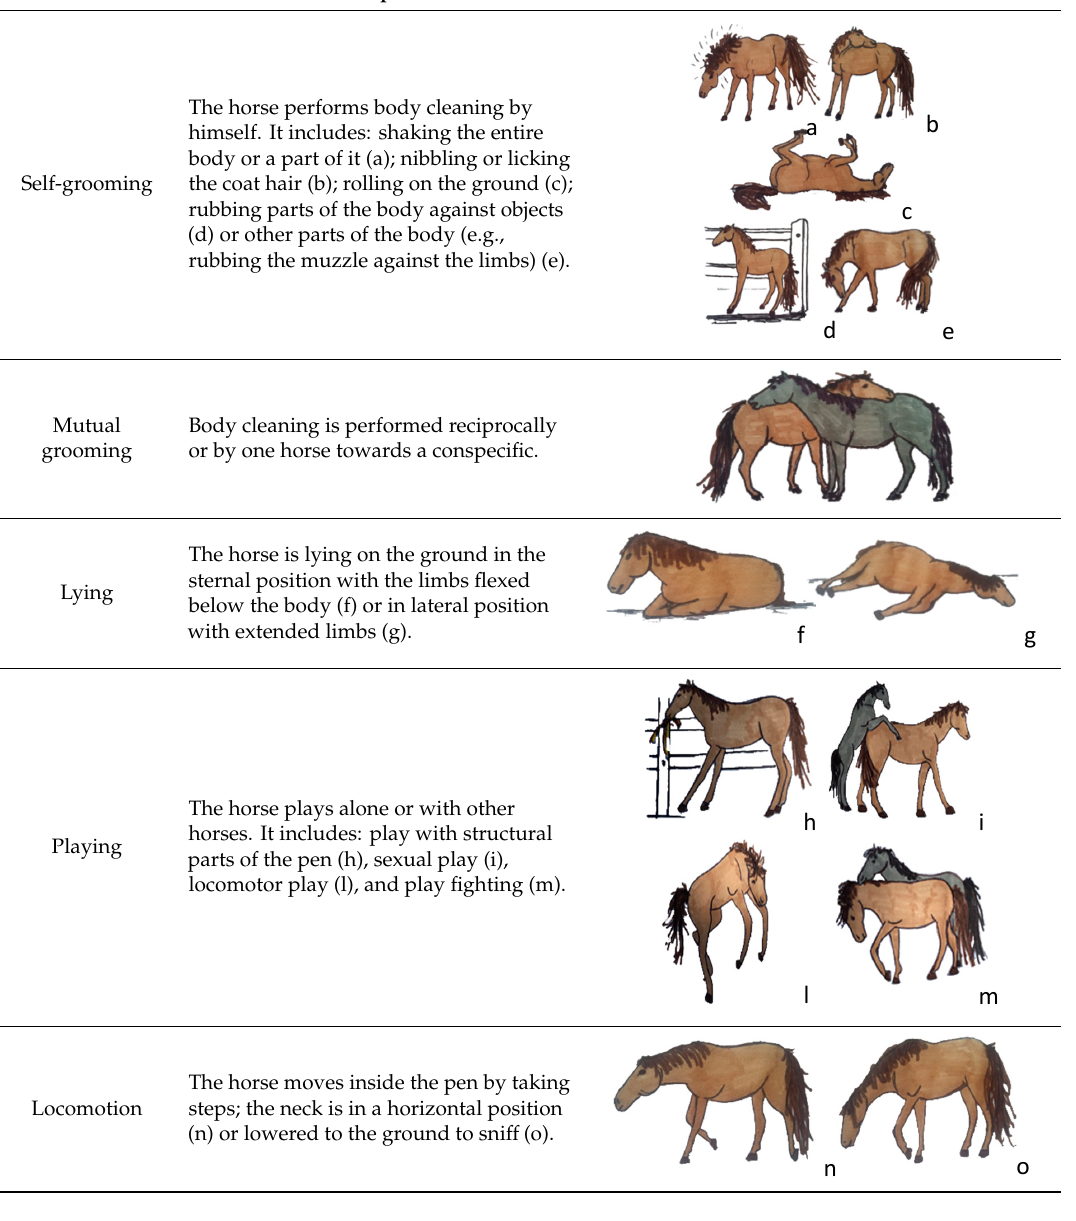
Table 2. Description and illustrations of the selected mutually exclusive behaviour